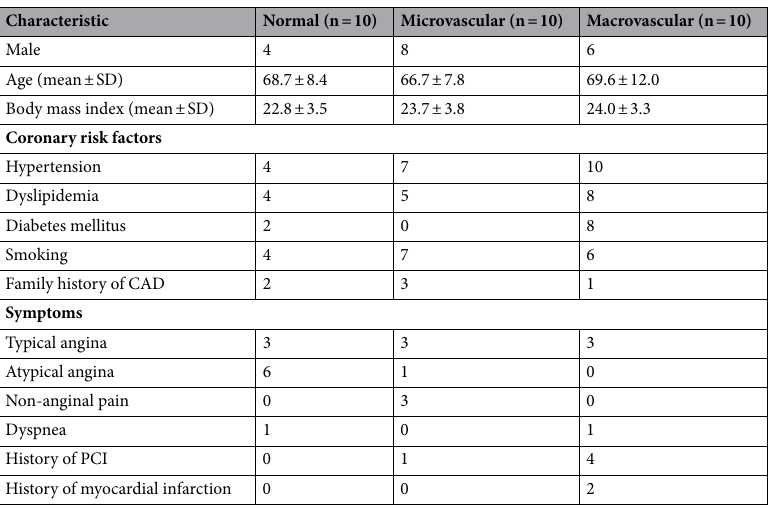
Table 1. Patient characteristics. SD—standard deviation, PCI—percutaneous coronary intervention.